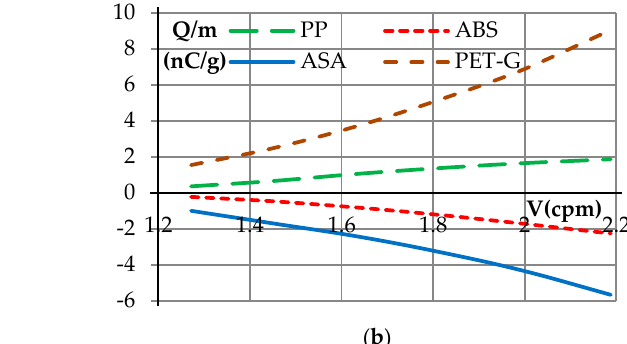
Figure 13. Charge density per mass as a function of airflow for tribocharging process of ( a ) PET, size of material 1.8–2.8 mm in the container made of PP, ABS, ASA, PLA; ( b ) PE-HD, size of material 1.8–2.8 mm, in the container made of PET-G, ABS, ASA and PP for a constant time of the charging process t = 30 s for fraction mass 10 g.